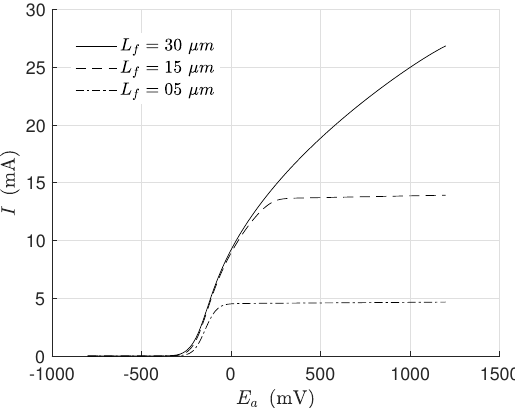
Figure 5. Numerical solution for the MEC model during voltammetry operation. Biofilm thickness effect on current dynamical behavior.